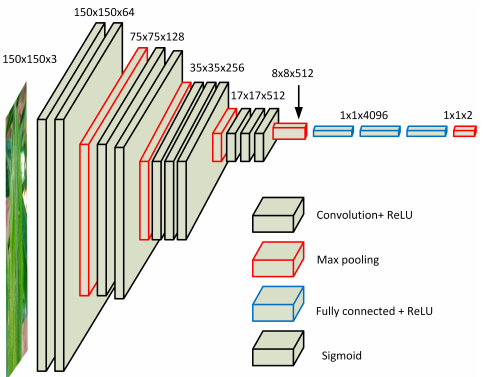
Figure 4. VGG-16 architectural model modified after